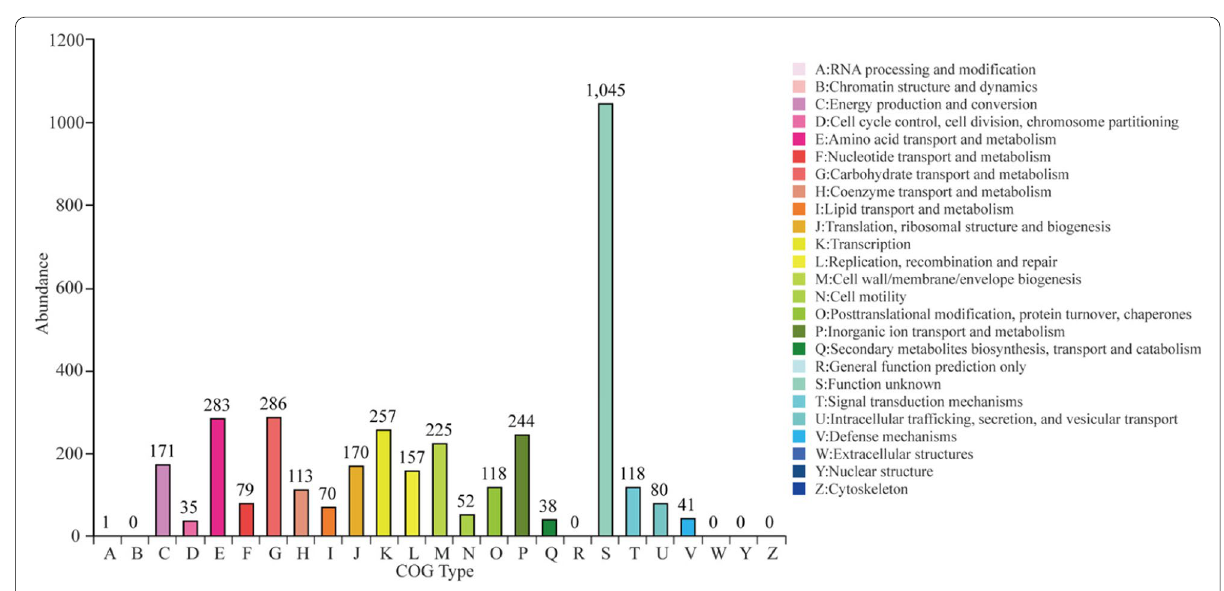
Fig. 6 COG annotation results of mutant strain YSD YN2 genome